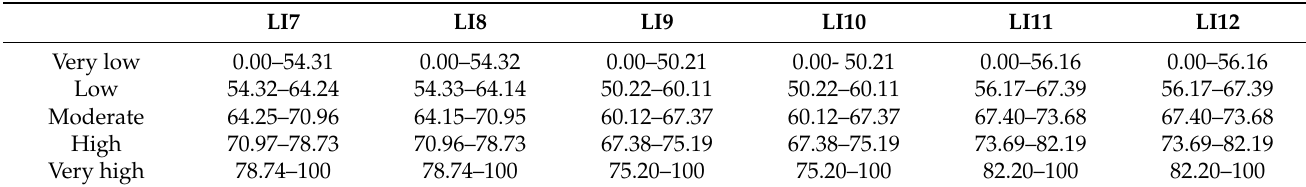
Table A8. Thresholds between the susceptibility classes for the models created with the LI